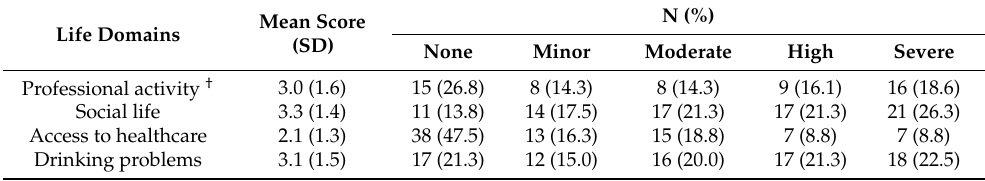
Table 2. Reported impact of COVID-19 on four life domains in patients with alcohol use